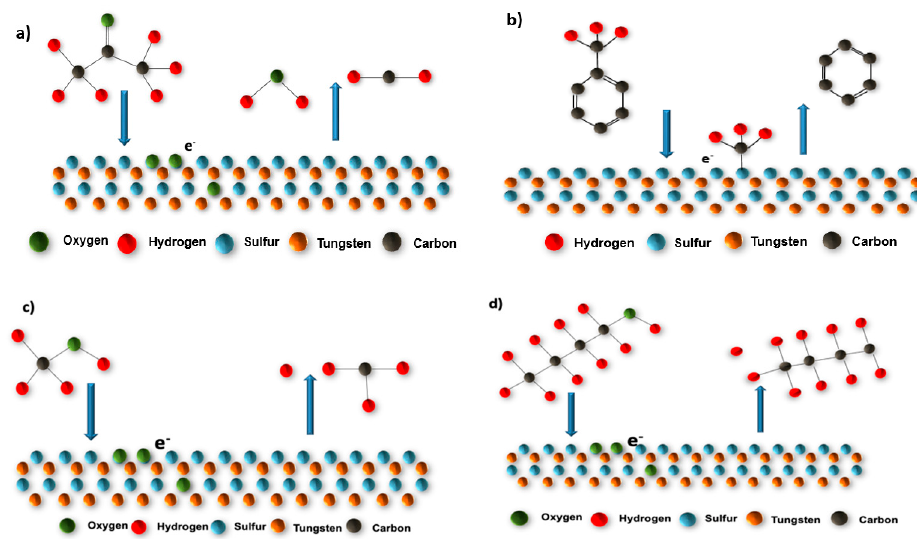
Scheme 3. Graphical illustration of O and methyl absorption onto the surface of the WS 2 nanotubes: ( a ) absorption of O from acetone, ( b ) absorption of methyl from toluene on the surface of WS 2 nanotubes, ( c ) absorption of O from methanol, and ( d ) absorption of O from